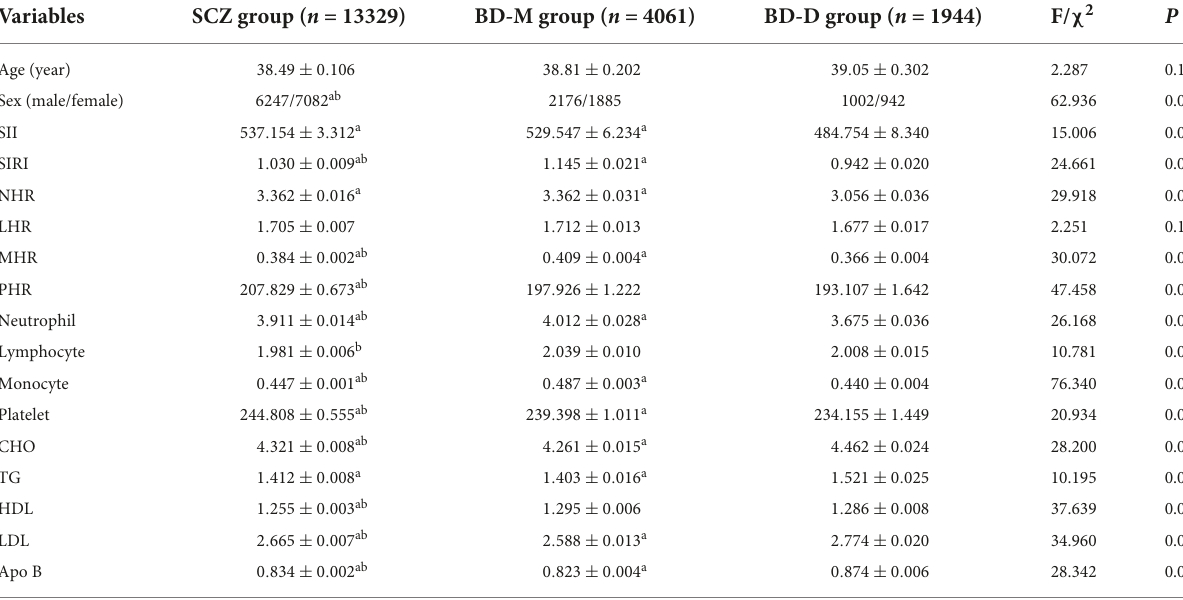
TABLE 3 Comparison of demographic features and laboratory indicators between BD manic episodes (BD-M), BD depressive episodes (BD-D), and healthy controls